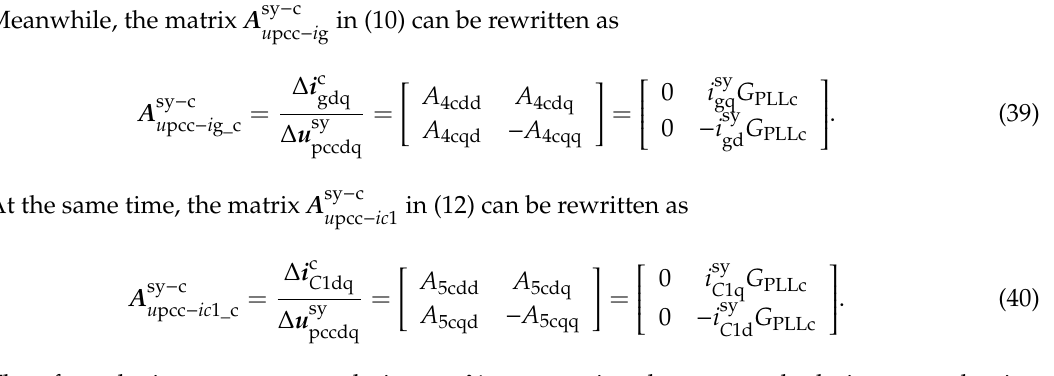
Figure 12. The control block diagram of the improved PLL.